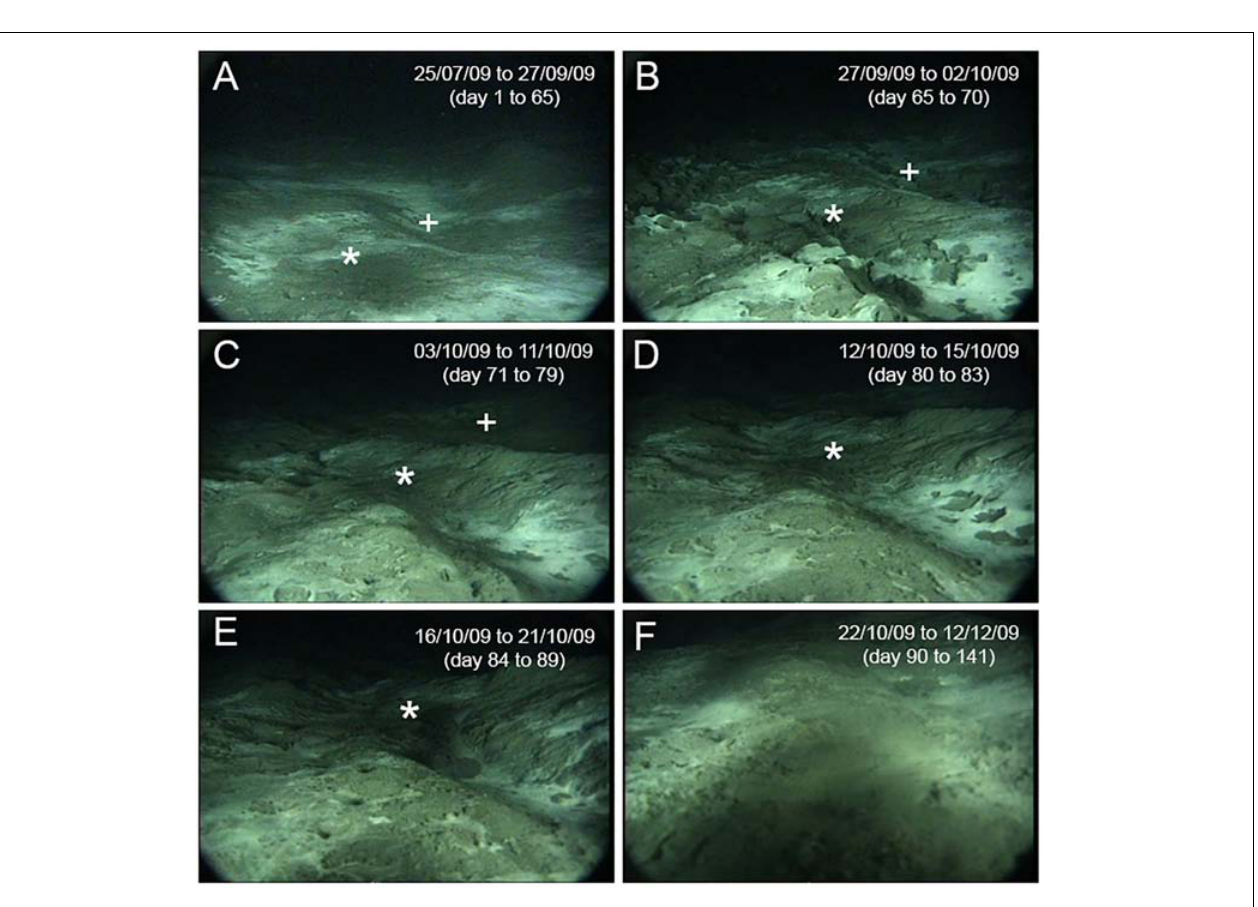
FIGURE 2 | Field of view of the autonomous imaging module (A) before and (B–F) after the mud eruption. The effect of the eruption on the AIM position is clearly visible. Five different field of view categories were identified after the eruption (B–F) with (F) representing the last video recorded by the AIM. Seabed surfaces visible within the field of view: (A) 2.6 m 2 , (B) 1.6 m 2 , (C) 1.3 m 2 , (D) 0.6 m 2 , (E) 0.3 m 2 and (F) ≤ 0.2 m 2 . Common features between images are indicated (* or